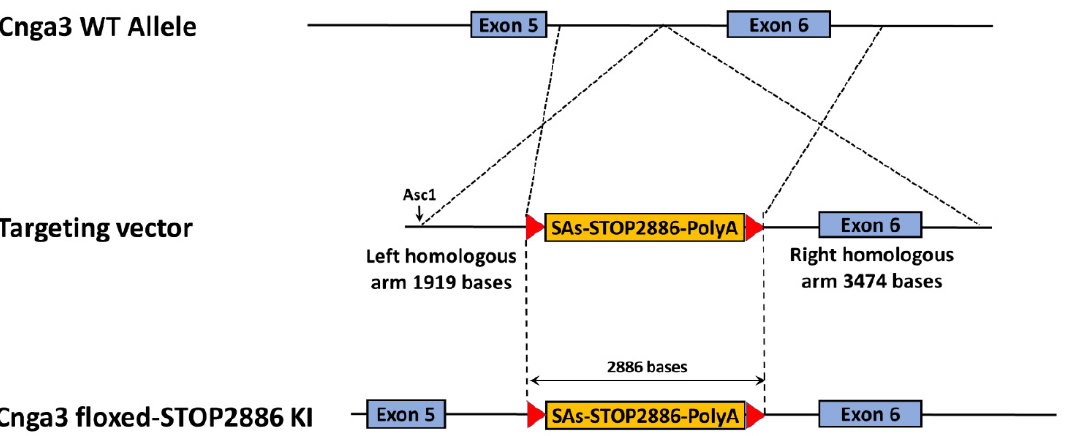
Figure 4. Generation of Cnga3 floxed-STOP mice using embryonic stem (ES) cell gene targeting. We inserted a “ floxed - STOP ” (2886 base pairs) cassette into the intron between exon 5 and exon 6 of the Cnga3 gene using ES cell gene